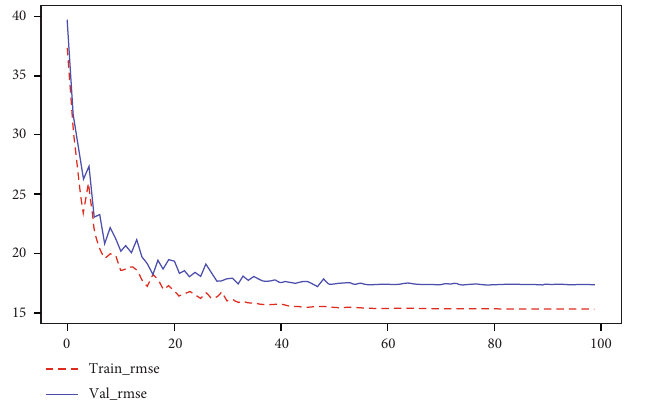
Figure 9: The change of RMSE of metro tra ffi c fl ow prediction model based on knowledge graph representation